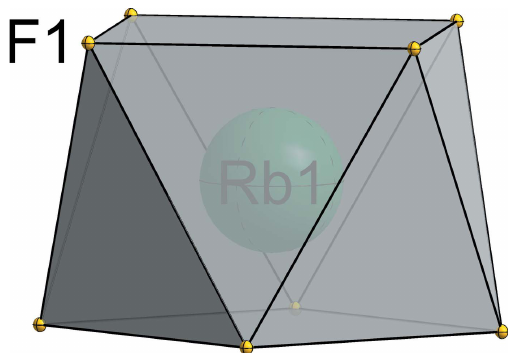
Figure 1 The square-antiprismatic coordination sphere of the Rb + cation by F (cid:2) anions. Atoms are shown with arbitrary